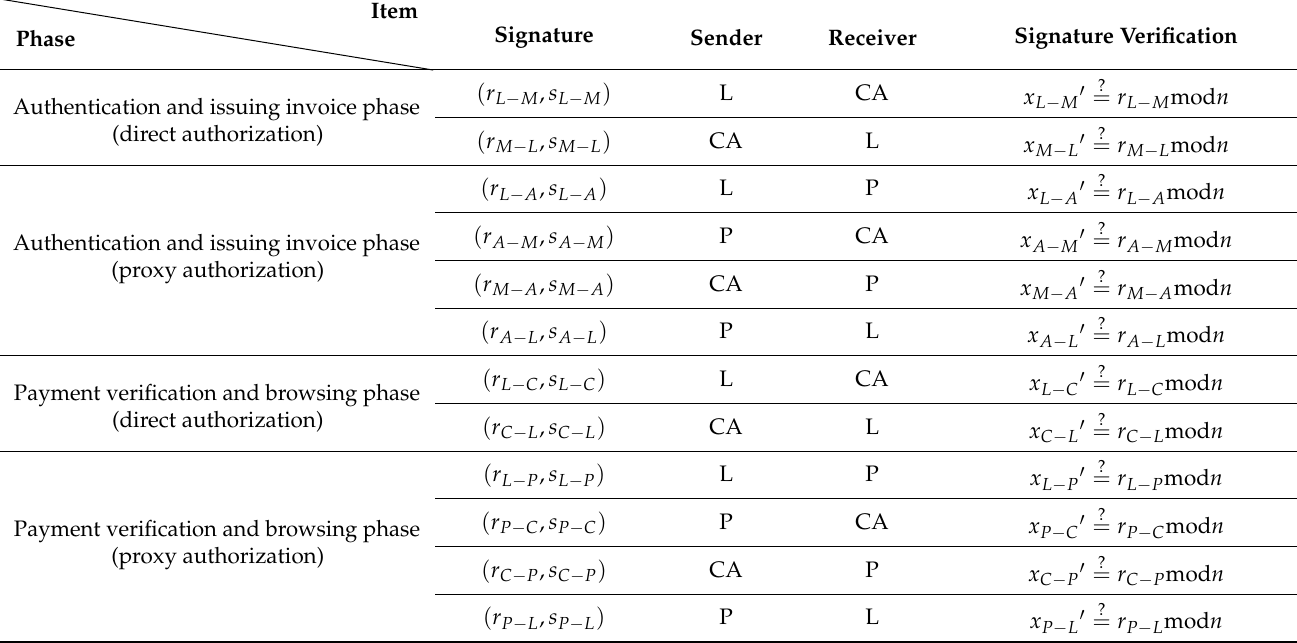
Table 1. Non-repudiation of the proposed